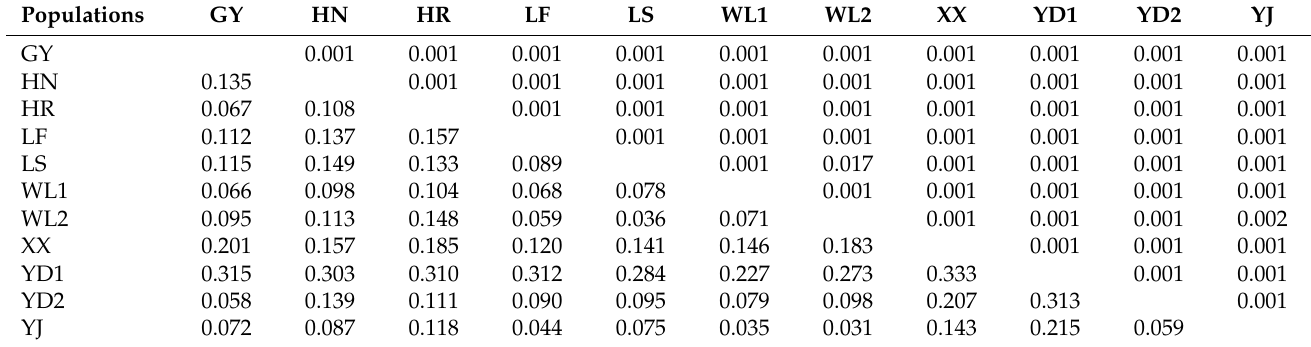
Table 6. Genetic differentiation ( F ST ) between pairs of geographic populations of F. commune causing strawberry root rot in southcentral China. The analysis here is based on a total sample of 354